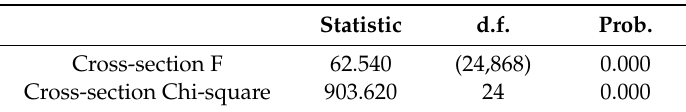
Table 3. F-test results.